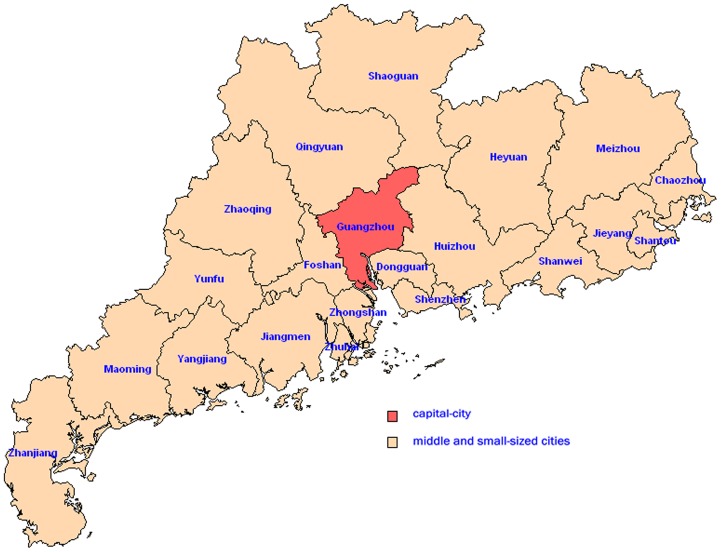
Twenty-one cities of Guangdong province were applied by a multi-stage stratified and cluster random sampling for sample selection in each survey.Guangdong province, including one capital-city (Guangzhou city) and twenty middle and small-sized cities, was divided into three population strata: a) the core area of the capital city, b) prefectures of other urban areas and c) prefectures of rural areas. At least two districts in each of the three population strata were randomly selected.